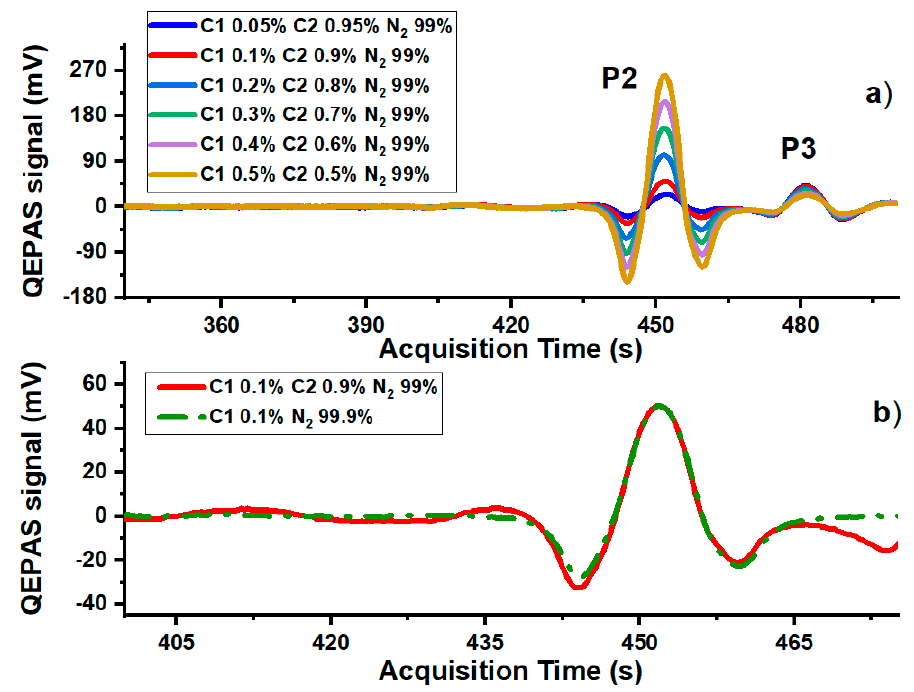
Figure 6 . ( a ) 2f-signals in the LD2 range measured for six mixtures of C1, C2 and N2. ( b ) Comparison of 0.1% of LD2 methane QEPAS signals between mixtures containing 99.9% nitrogen, and 99% nitrogen and 0.9% of ethane.